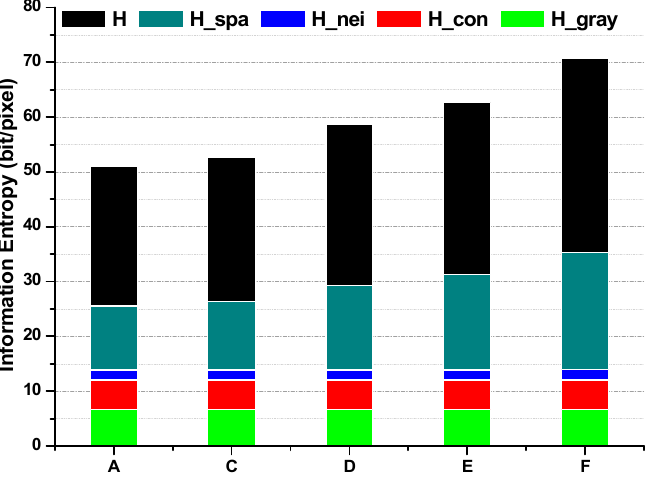
15 of 21 Figure 11. Spatial exchange of local area of remote sensing image. ( A ) Original image, ( B ) block grid, ( C ) exchange (a)–(e) sub-blocks in original image, ( D ) increase exchange (b)–(d) sub-blocks, ( E ) add exchange (c)–(g) sub-blocks, and ( F ) add exchange (h)–(f) sub-blocks. As shown in Figure 12 and Table 2, grayscale entropy does not change after the local sub-blocks are exchanged. In addition, since the scale of the exchanged sub-blocks is rel- atively large compared to the pixels, the pixels whose local space changes in each sub- block are mainly at the edge and the number is much smaller than the pixels inside the sub-block image. Therefore, the images’ contrast and neighborhood topological infor- mation did not change significantly. Fortunately, the spatial distribution information changes significantly as the overall spatial structure of the image changes, indicating that it captures the changes occurring in the overall spatial structure of the image. Therefore,